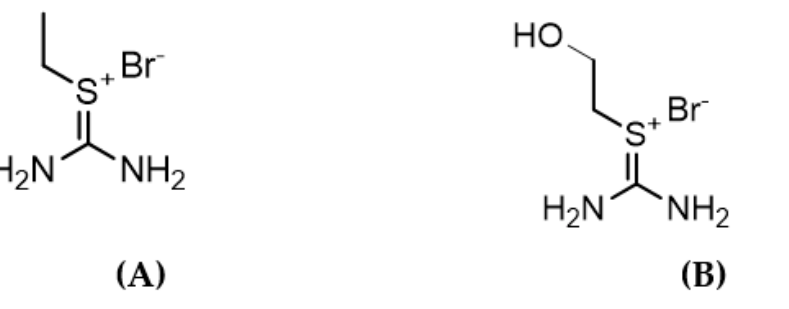
Figure 1. Structures of the ionic liquids used in this work. ( A ) 2-ethylthiouronium bromide and ( B ) 2-(hydroxyethyl)thiouronium bromide.